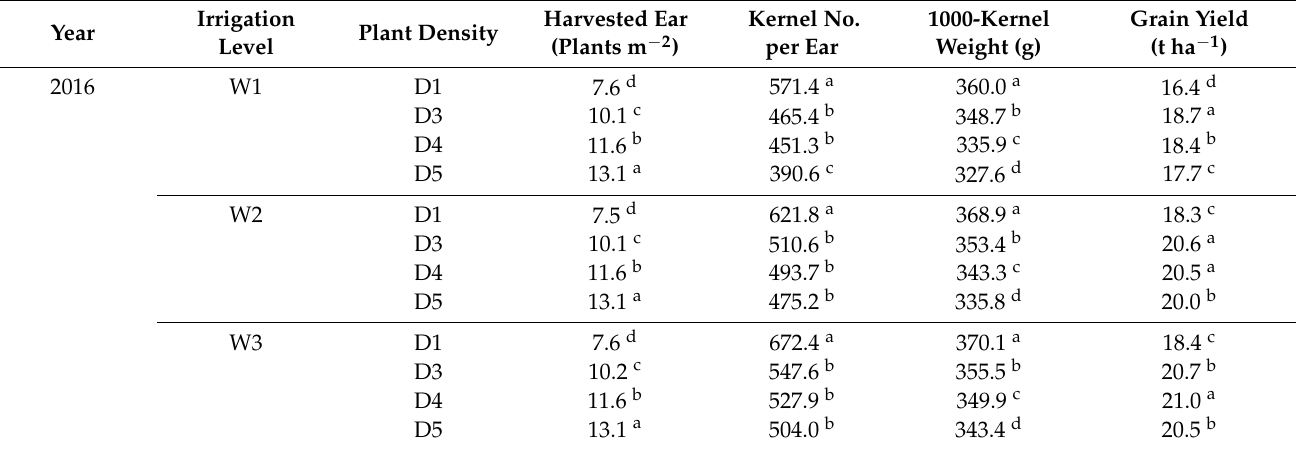
Table 1. Harvested ear, kernel no. per ear, 1000-kernel weight, and grain yield of maize under different irrigation and planting densities in 2016 and